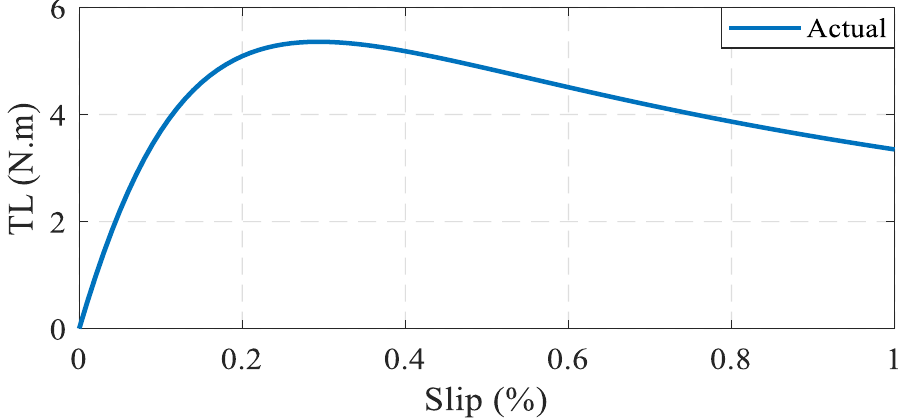
Figure 12shows the torque slip characteristics of the six-phase induction motor,